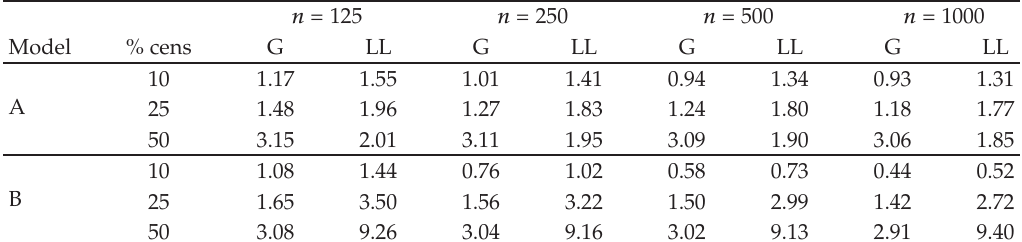
Table 1: Mean (cid:3) × 10 − 2 (cid:4) of L 2 error for the density function estimators. n (cid:7) 125